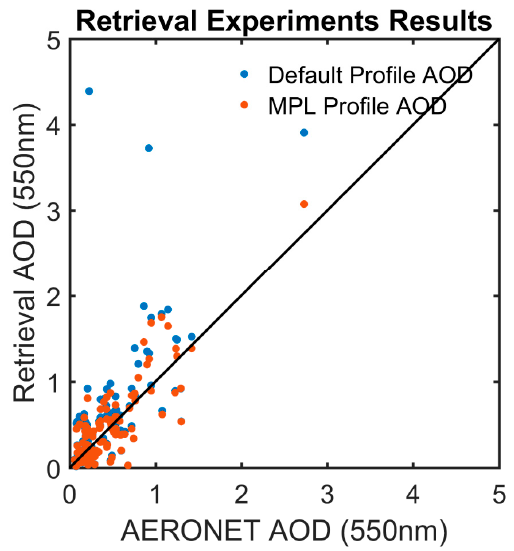
Figure 13. Scatterplots of AOD retrieved using the default profile (exponential decaying with scale height = 2 km) and the MPL-retrieved aerosol extinction profile.